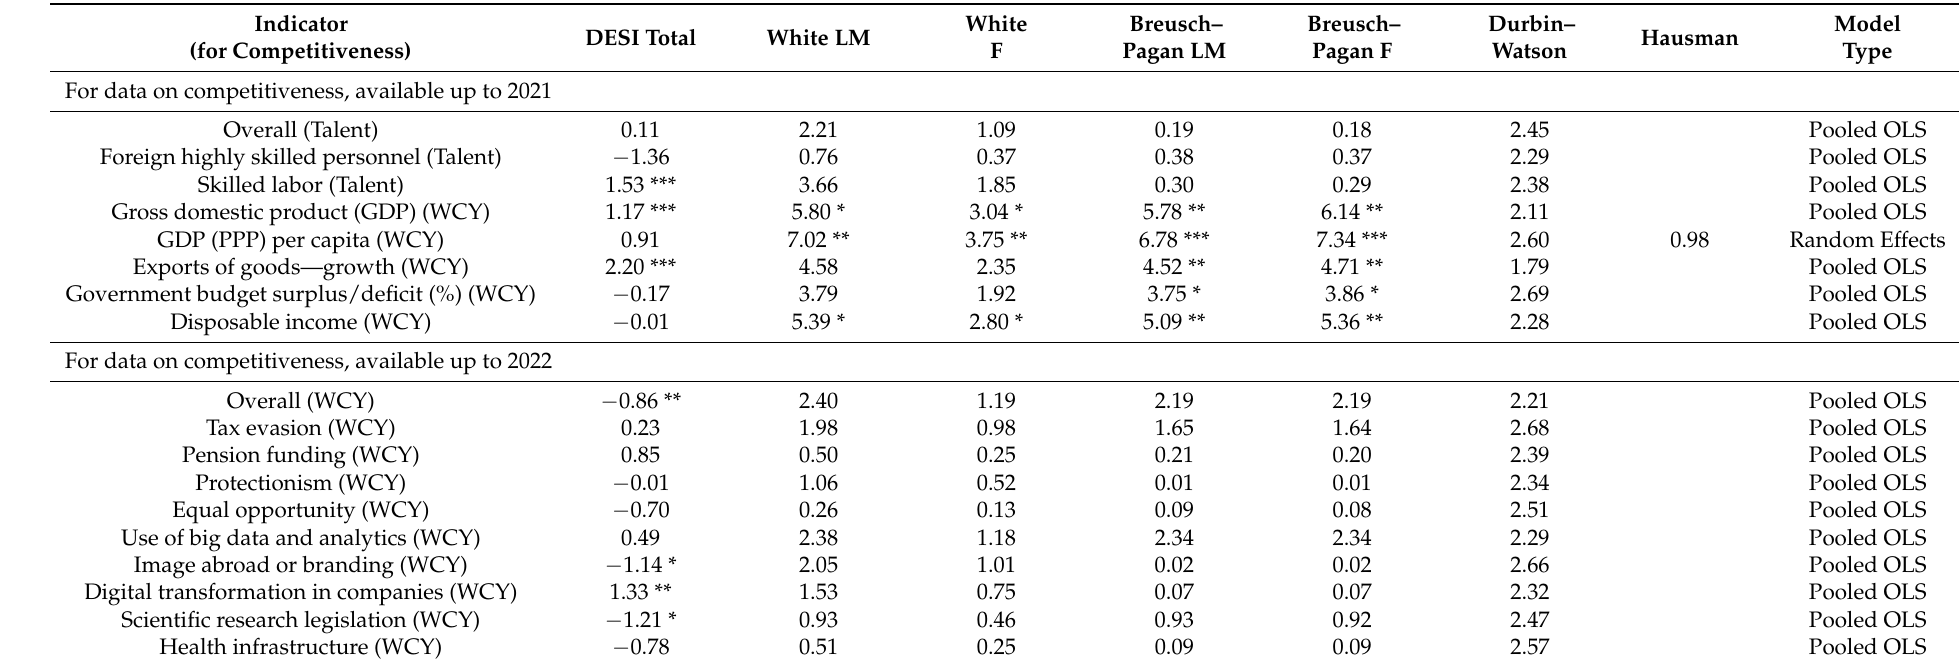
Table 4. Results for the scenario when the DESI total is considered for Western European